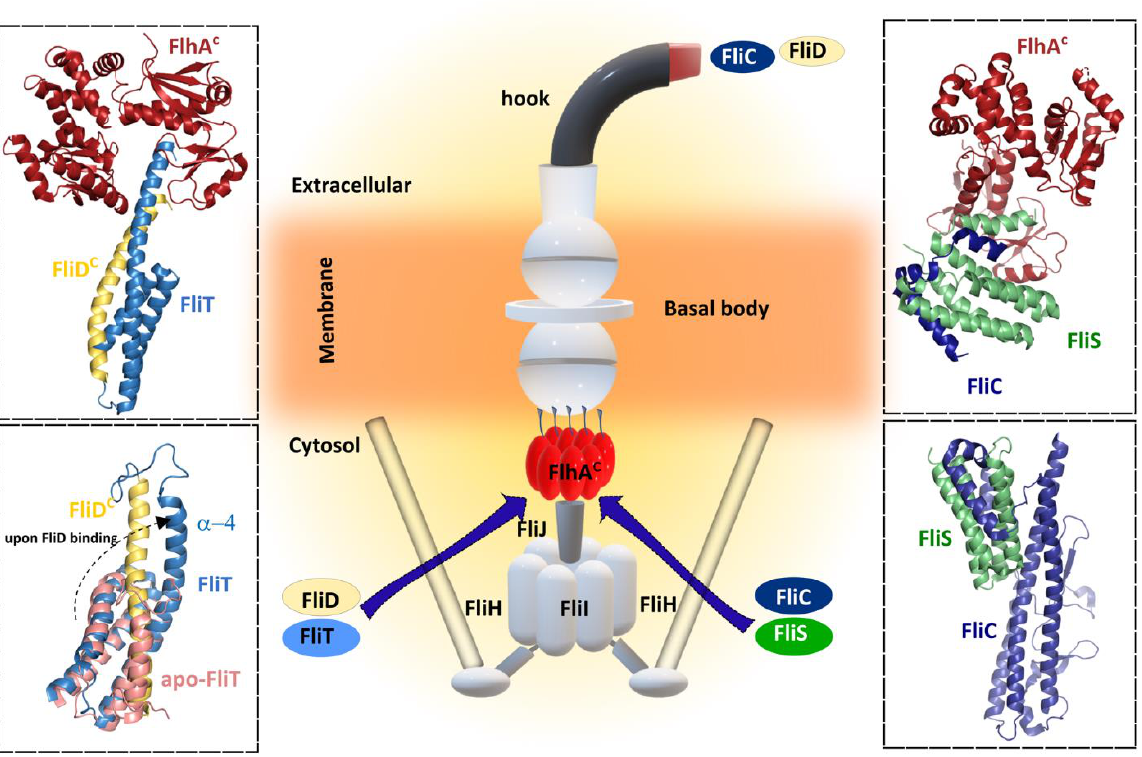
Figure 5. Bacterial flagellar filament proteins and their cognate specific chaperone form complexes with FlhA for filament exportation/synthesis. FliC and FliD proteins interact with each cognate chaperone FliS and FliT, respectively, before interacting with the cytosolic region of FlhA (FlhA C ). Upper left —Cartoon representation of crystal structure 6CH2 (FlhAC-FliT-FliD complex from Salmonella enterica subsp. enterica serovar Typhimurium str. LT2. Upper right —Cartoon representation of crystal structure 6CH3 (FlhAC-FliS-FliC complex) from Salmonella enterica subsp. enterica serovar Typhimurium str. LT2). Lower left —Superposition of cartoon representation of both NMR solution structures: 5KRW (FliD-FliT) and 5KS6 (apo-FliT) from Salmonella enterica subsp. enterica serovar Typhimurium str. LT2. The FliT helix α4 is released upon FliD binding. Lower right —Cartoon representation of crystal structure 5MAW (FliS-FliC complex) from B. subtilis . Center figure —simplified schematic representation of the main flagellar components.